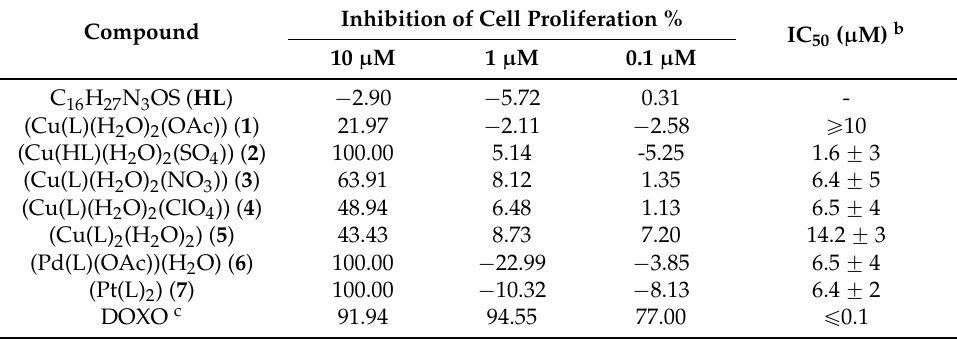
Table 4. Antiproliferative activity of ligand and metal complexes on human leukemia HL-60 cells at three concentrations a